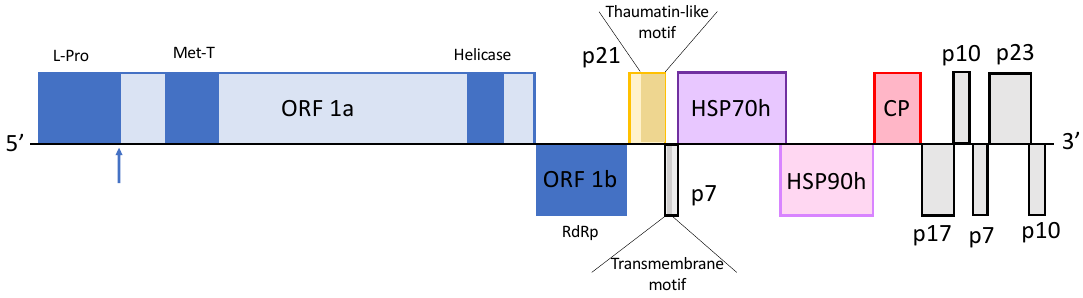
Figure 1. Genome organization of olive leaf yellowing-associated virus CS1 isolate. L-Pro: papain-like leader protease; Met-T viral methyltransferase domain; Helicase: viral helicase domain; RdRp: RNA dependent RNA polymerase. Blue arrow indicates tentative L-Pro cleavage site position.